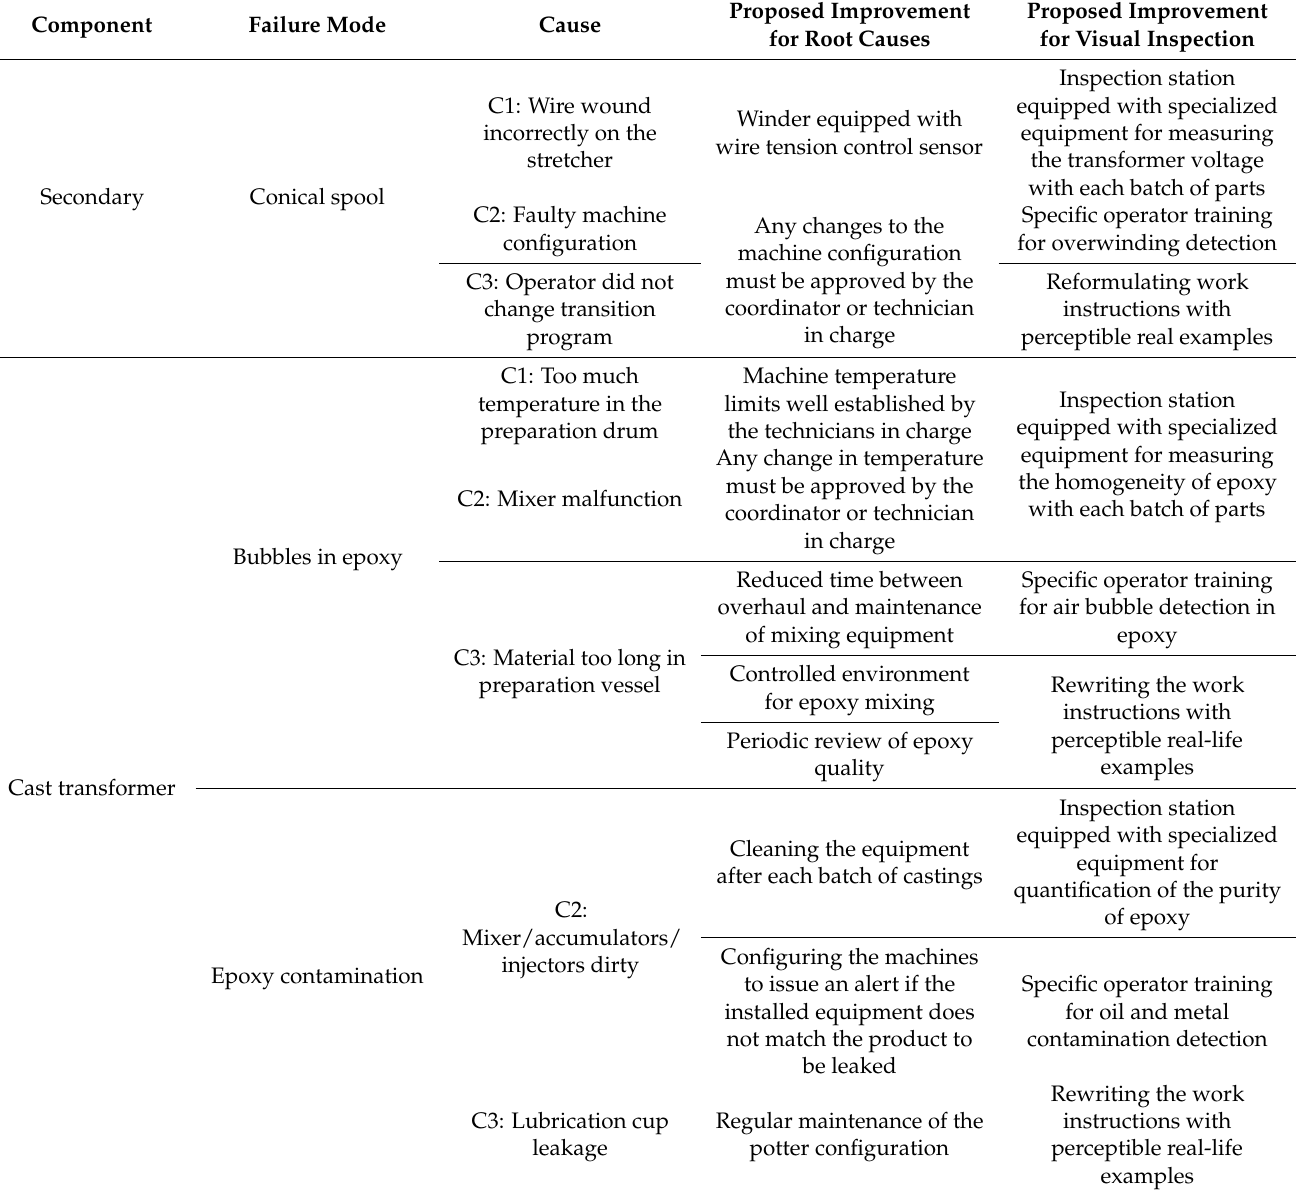
Table 8. Improvement measures for priority failure